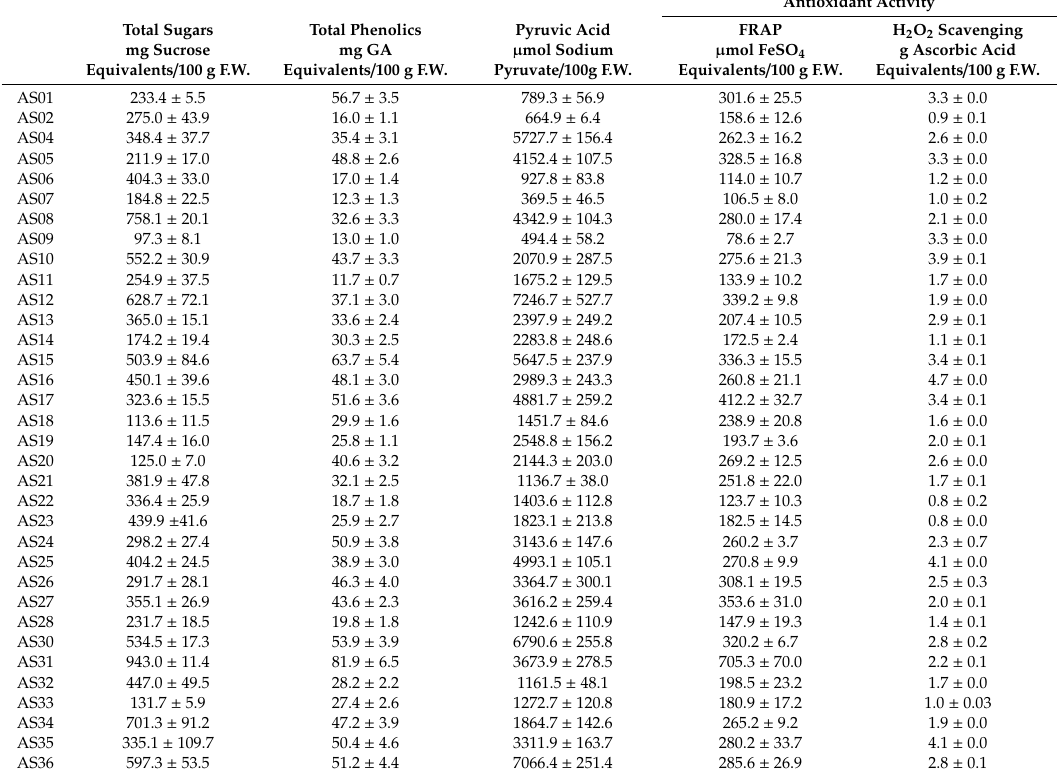
Antioxidant Activity